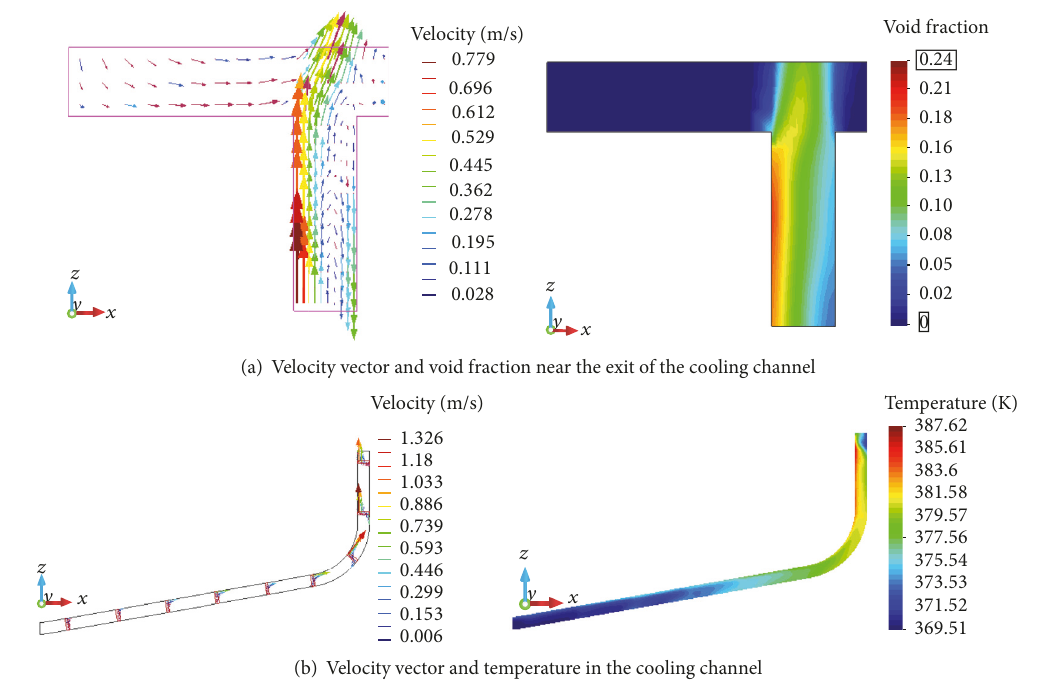
Figure 17: The CUPID calculation results for Case